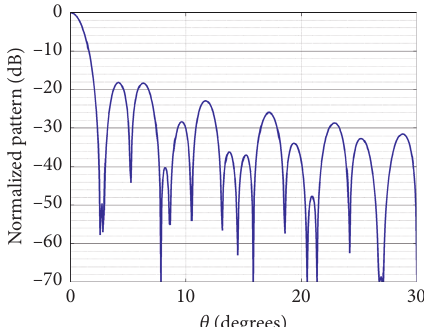
Figure 3: The array factor for N � 64 and M � 24. The 2 nd and 3 rd SLLs are approximately equal.